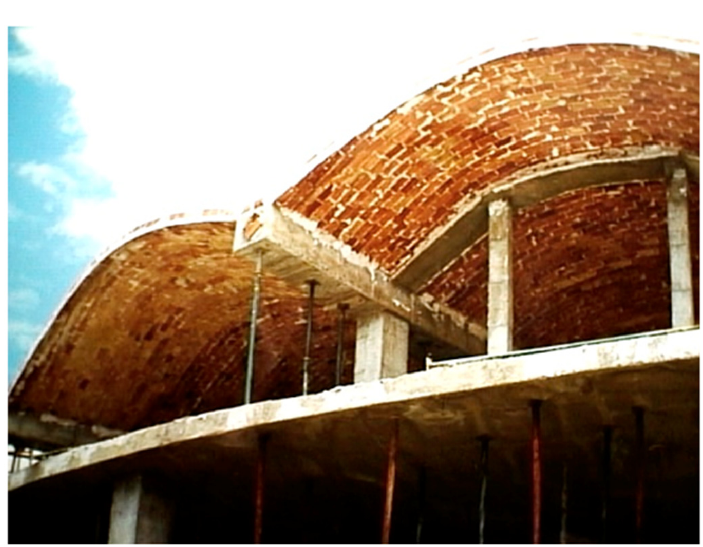
Figure 27. Vault pieces are constructed in hollow thin brick with steel mesh for reinforcement and attached to a concrete frame.